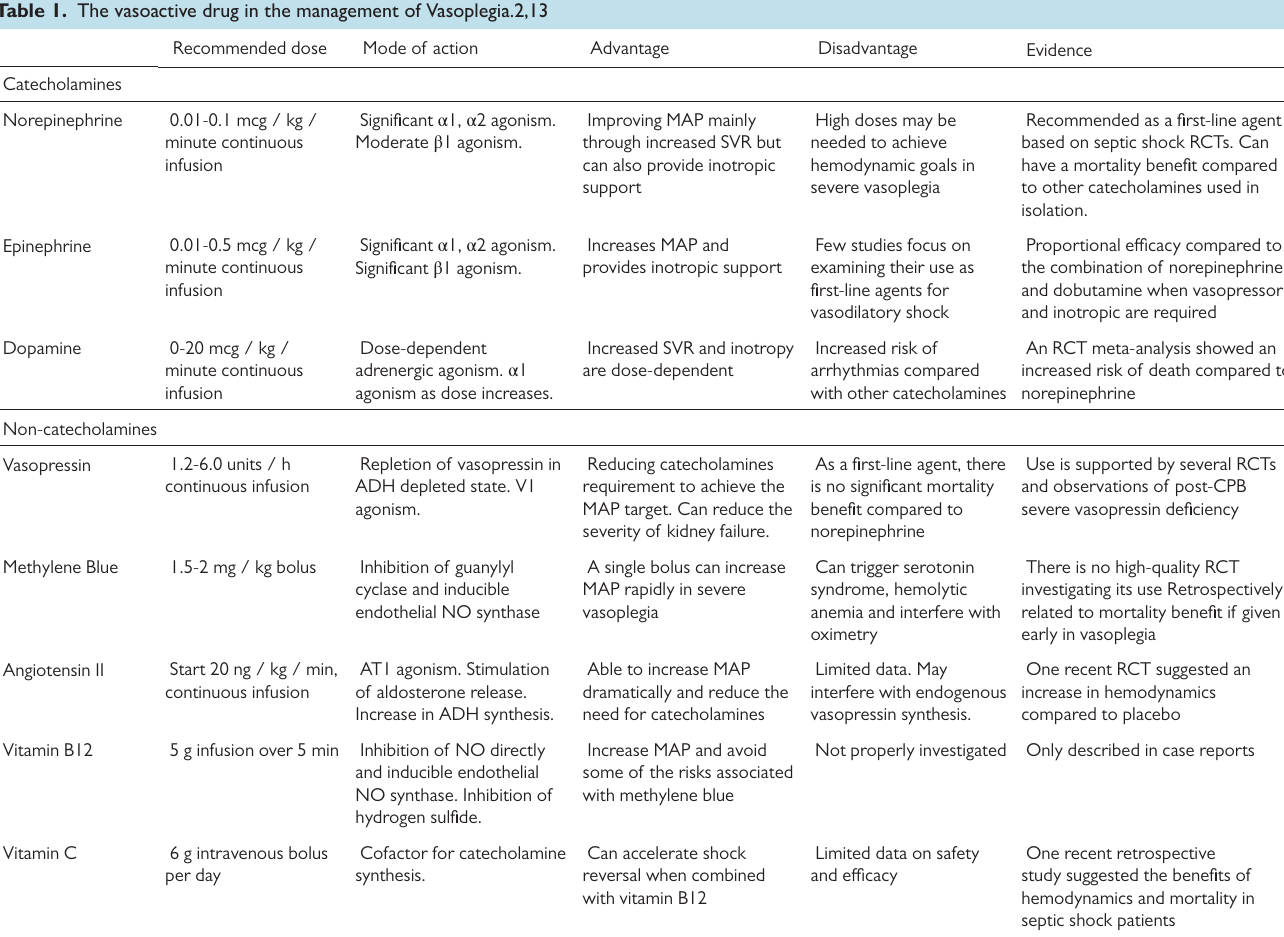
Table 1. The vasoactive drug in the management of Vasoplegia.2,13 Recommended